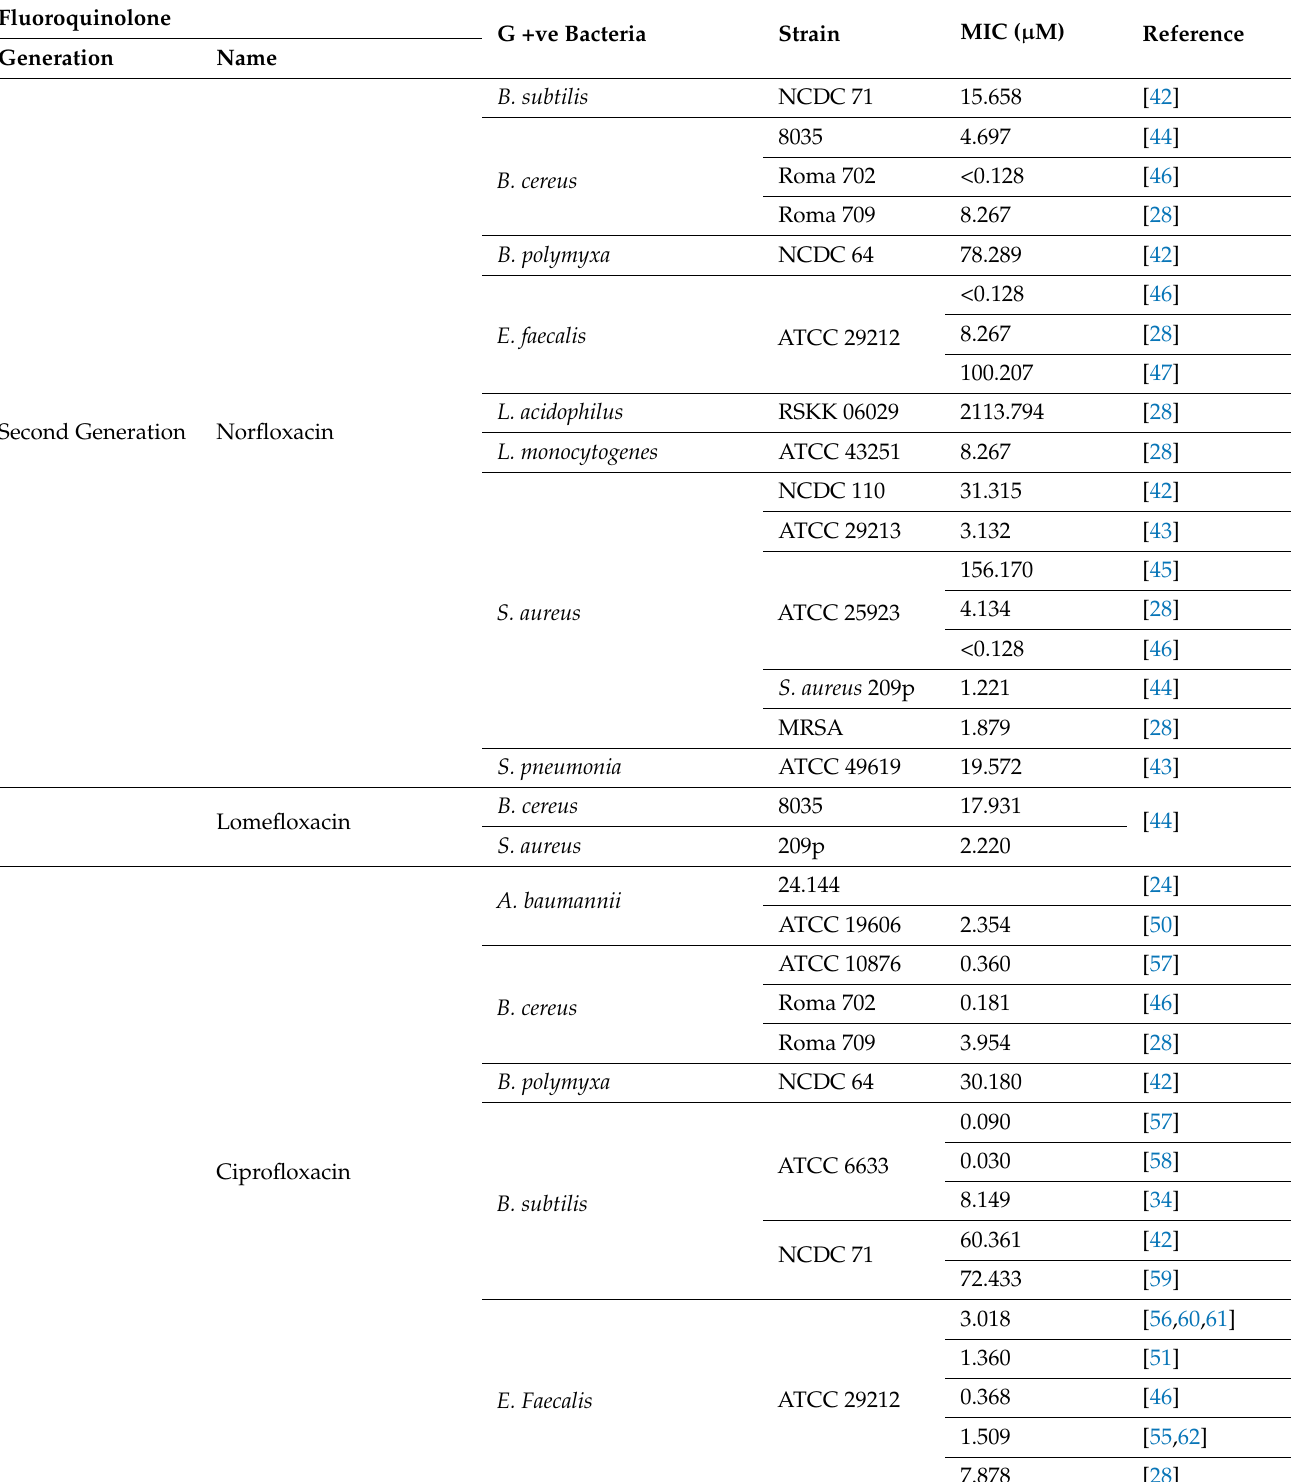
Table 3. Fluoroquinolones’ antibacterial activity against Gram-positive bacterial strains.